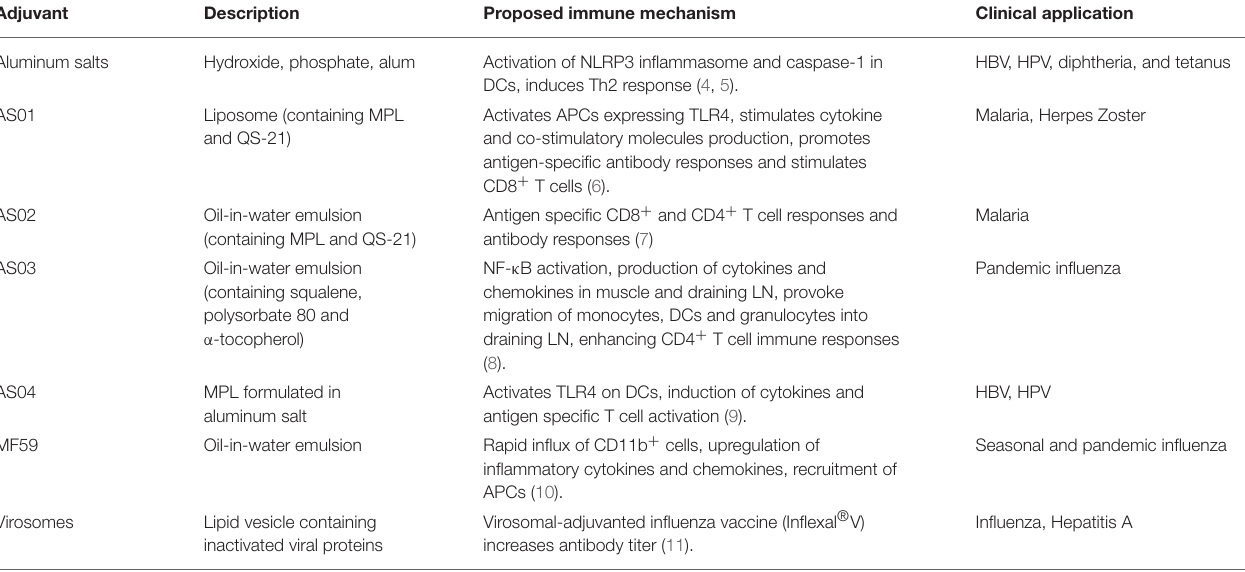
TABLE 1 | Clinically approved adjuvants.